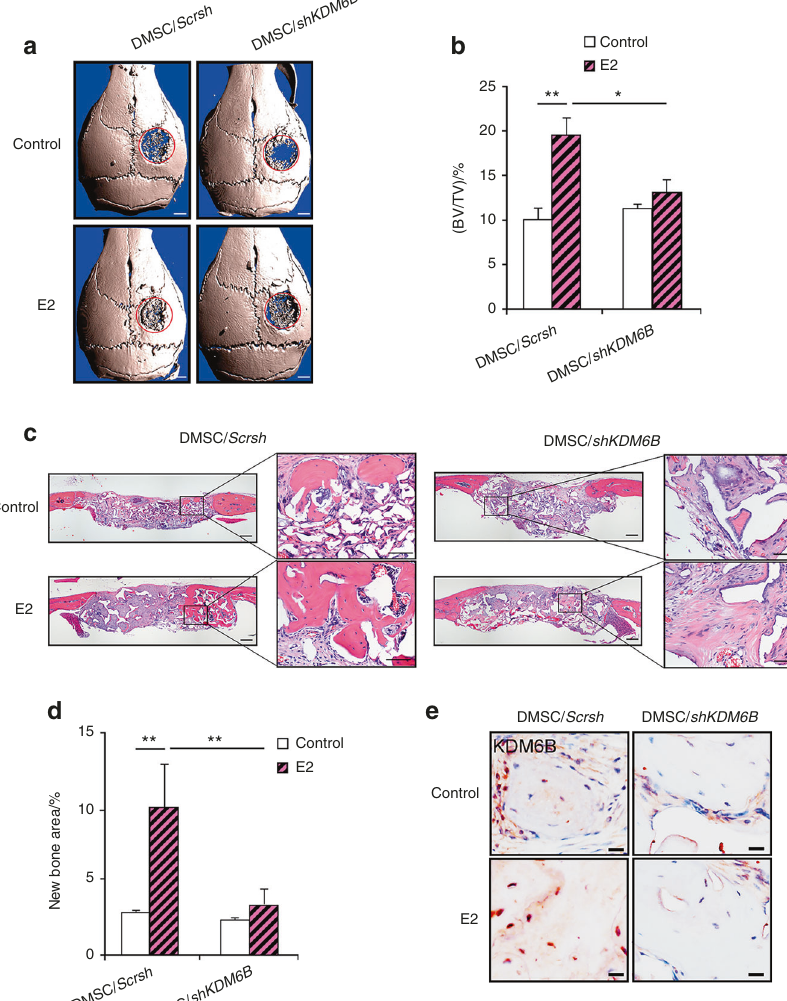
Fig. 6 KDM6B is required for E2-mediated DMSC bone formation in vivo. Micro-CT images ( a ) and bone volume quanti fi cation (BV/TV) ( b ) of calvarial bone defects with scaffolds containing DMSC/ shKDM6B and DMSC/ Scrsh with and without E2. Scale bars, 1 mm. H&E staining images ( c ) and histomorphometric analysis for new bone area within calvarial bone defects ( d ) from mice with transplanted scaffolds seeded with DMSC/ shKDM6B and DMSC/ Scrsh with and without E2. Scale bars, 200 μ m. e Immunostaining of KDM6B in bone tissue formed on scaffolds. Scale bars, 25 μ m. Data are presented as the mean ± SEM ( n = 4). For b and d , all the groups were compared by two-way ANOVA with a Bonferroni post hoc test. Asterisks were assigned to P values with statistical signi fi cance (* P < 0.05; ** P <